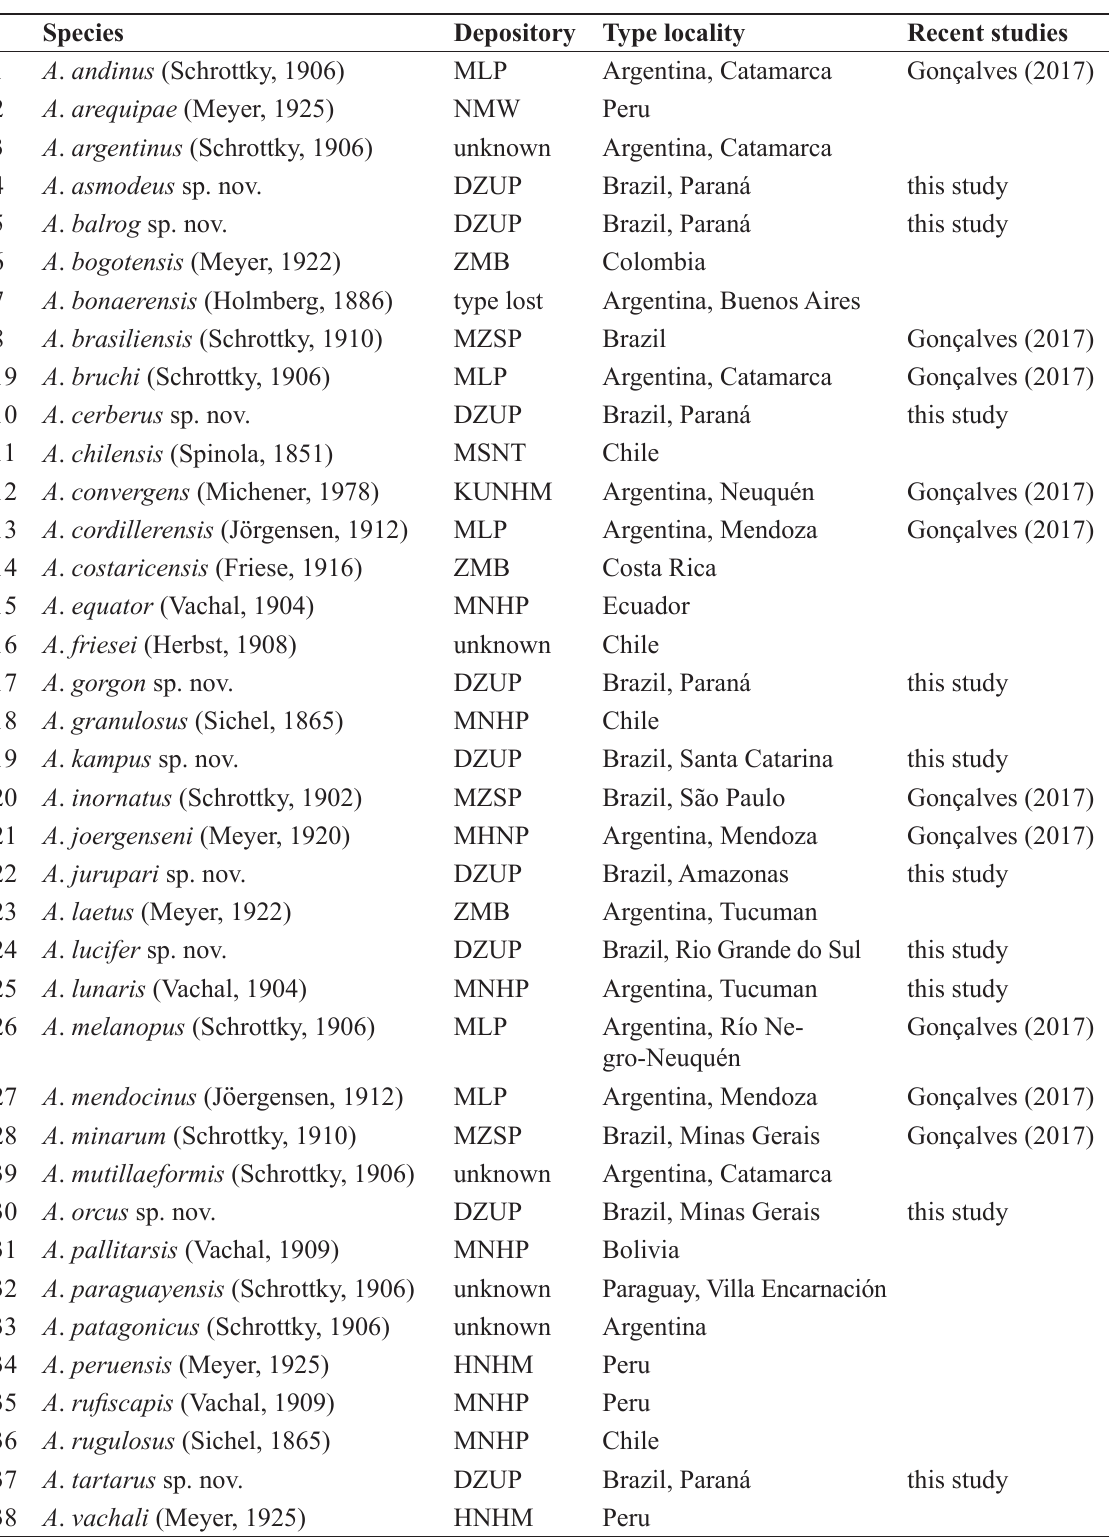
Table 2. Species of Austrosphecodes Michener, 1978, depositories, type localities and recent descriptions/